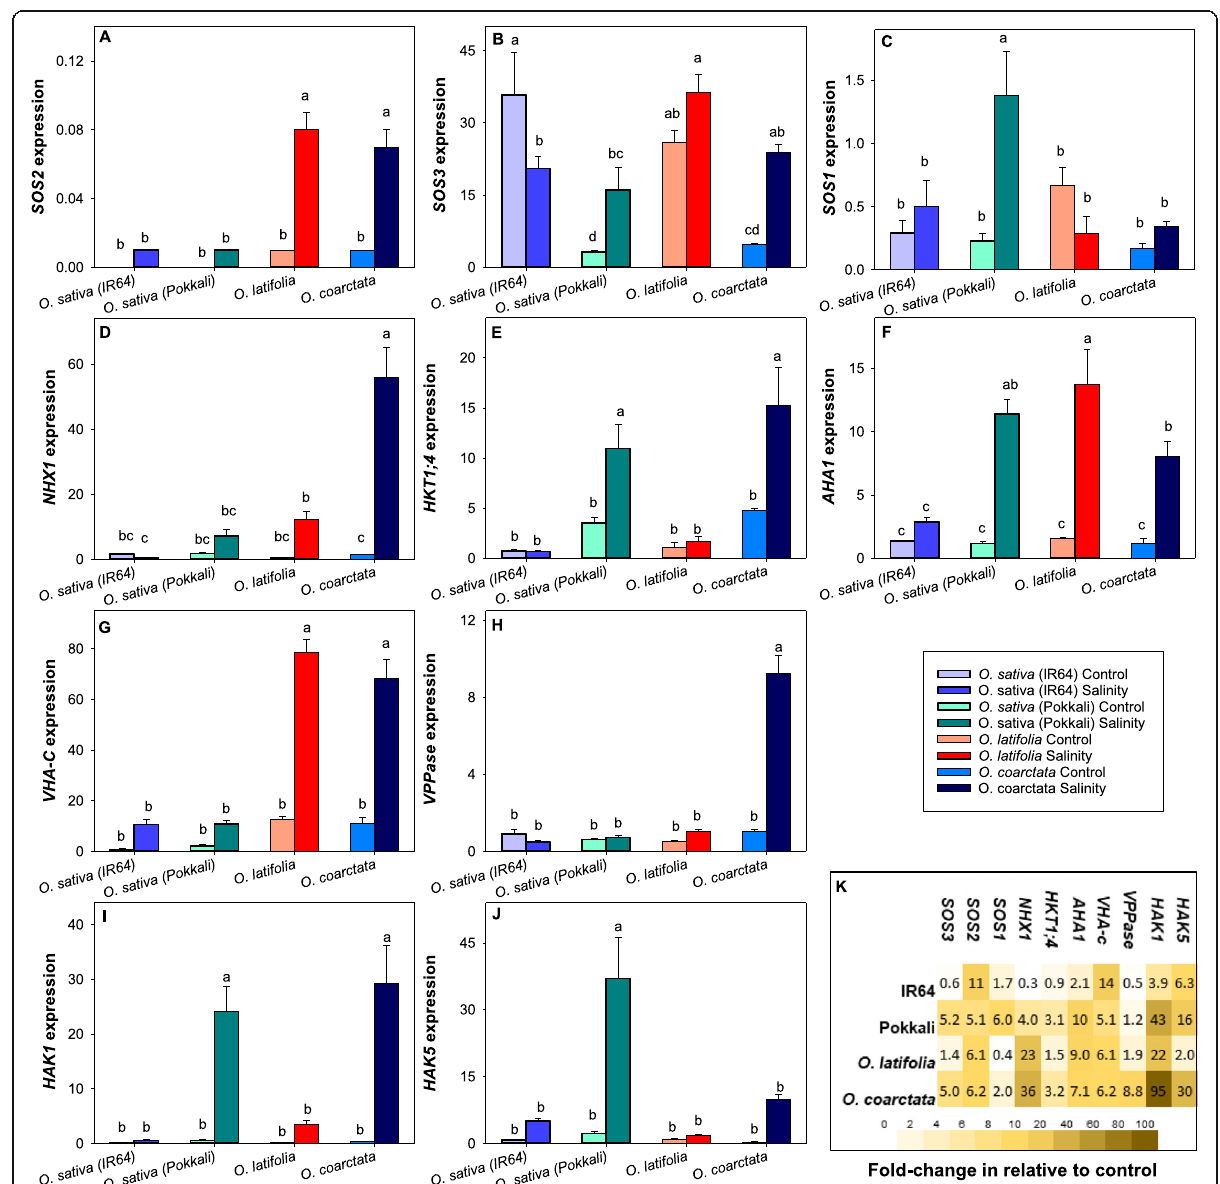
Fig. 7 Expression of salinity tolerance-related genes in the leaf of wild and cultivated rice after 42 days of 100 mM NaCl treatment. ( A ) SOS2, ( B ) SOS3, ( C ) SOS1, ( D ) NHX1, ( E ) HKT1;4, ( F ) AHA1, ( G ) VHA-C, ( H ) VPPase , ( I ) HAK1 and ( J ) HAK5. ( K ) Fold change of genes after salinity treatment is relative to the control. Data are mean of 3 technical replicates (each containing at least 3 technical replicates) and the error bars indicate the standard errors. Different lowercase letters indicate significant differences at P < 0.05 for each Duncan